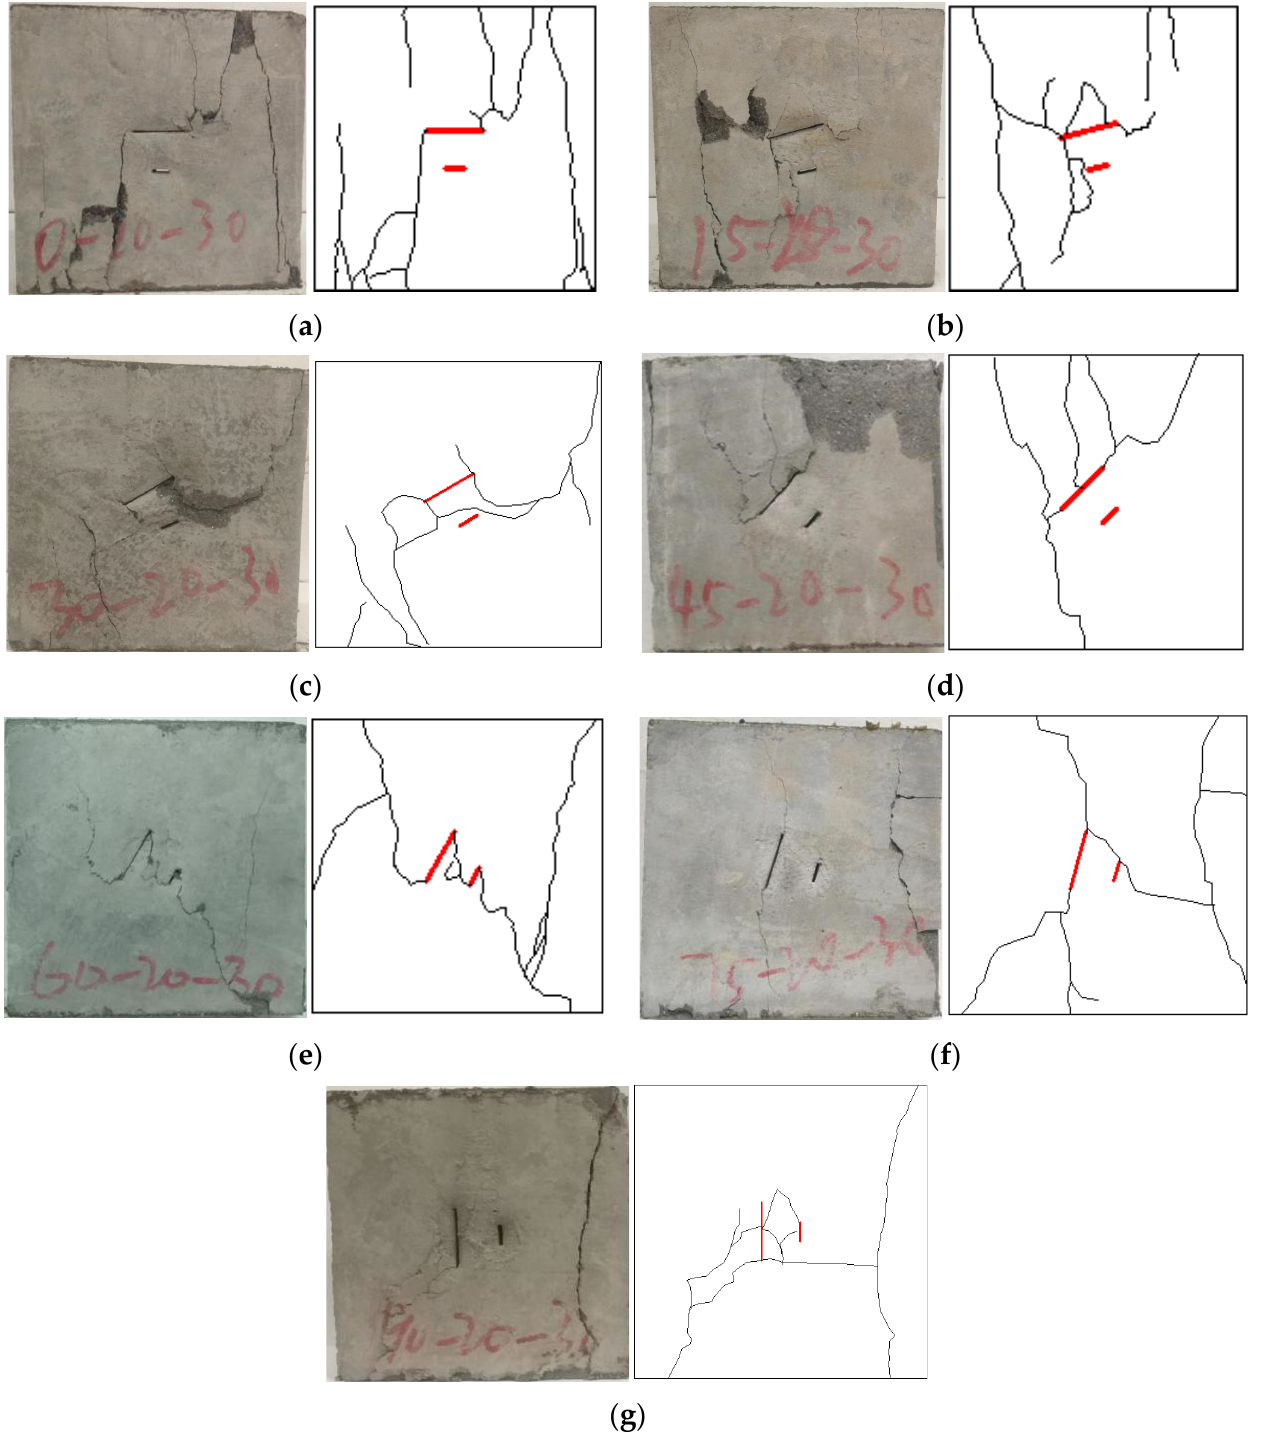
Figure 8. Influence of the preexisting fissure angle on crack propagation and coalescence. ( a ) Failure specimen 0-20-30; ( b ) 15-20-30; ( c ) 30-20-30; ( d ) 45-20-30; ( e ) 60-20-30; ( f ) 75-20-30; and ( g ) 90-20-30.